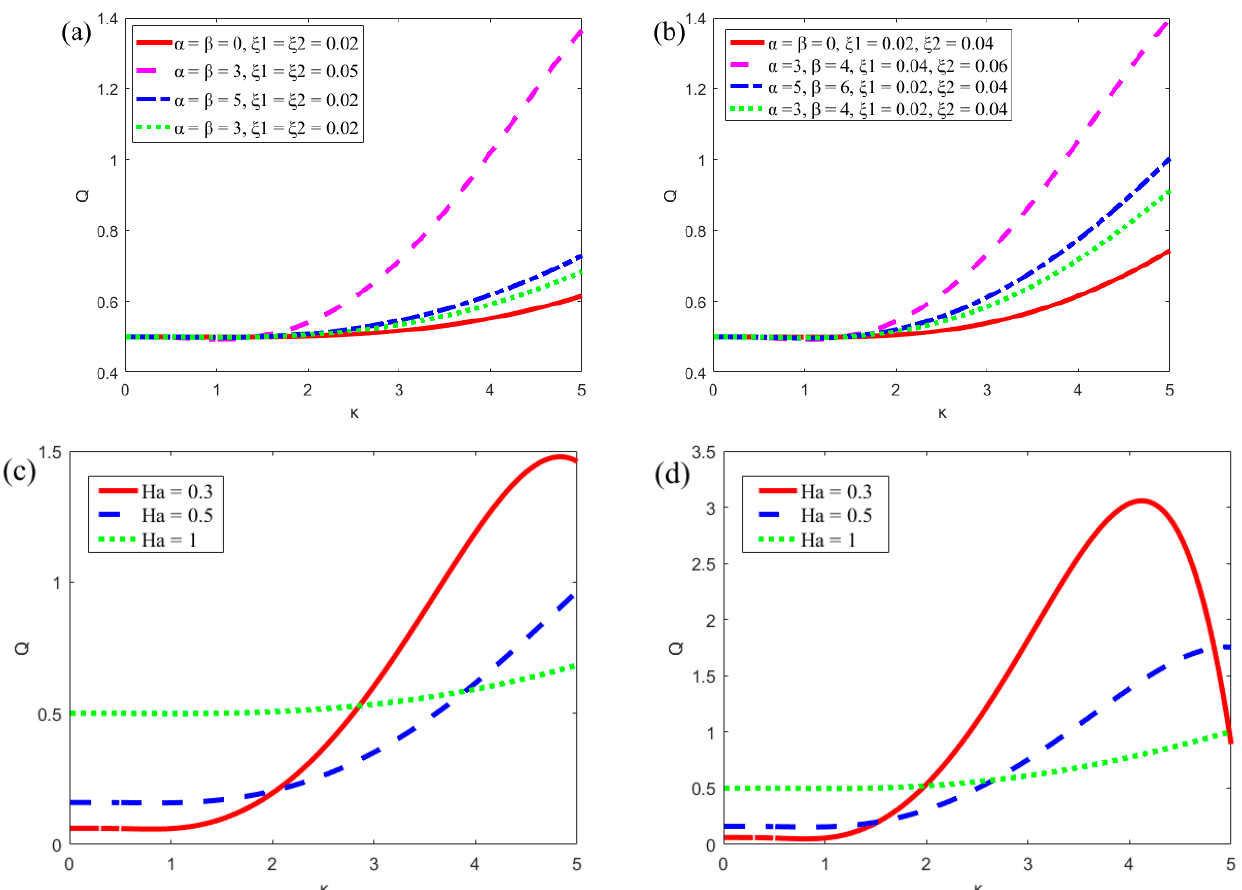
Figure 8. The variations of the flow rate in microchannel of the parallel plate ( δ = 0.02, u r = 1, R = 1). ( a ) Symmetric modulated potentials with different α , β , ξ 1 and ξ 2 ( m = n = 0.5, Ha = 1); ( b ) Asymmetric modulated potentials with different α , β , ξ 1 and ξ 2 ( m = 0.5, n = 0.8, Ha = 1). ( c ) Symmetric modulated potentials with different Ha ( m = n = 0.5, ξ 1 = ξ 2 = 0.02, α = β = 5); ( d ) Asymmetric modulated potentials with different Ha ( m = 0.5, n = 0.8, ξ 1 = 0.02, ξ 2 = 0.04, α = 5, β = 6).